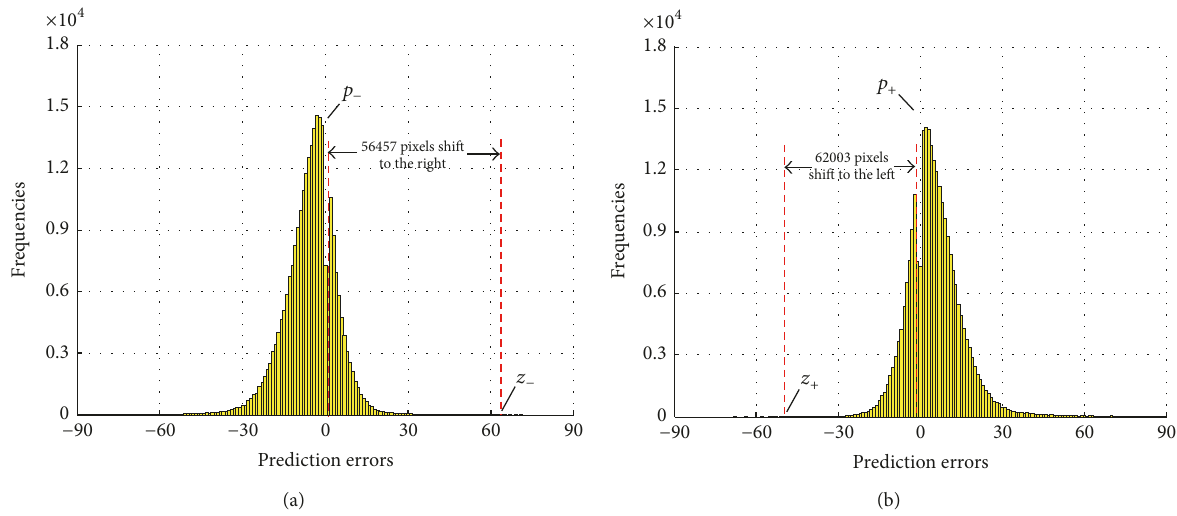
Figure 3: The maximum and minimum asymmetric histograms ℎ + (𝑒) (a) and ℎ − (𝑒) (b).